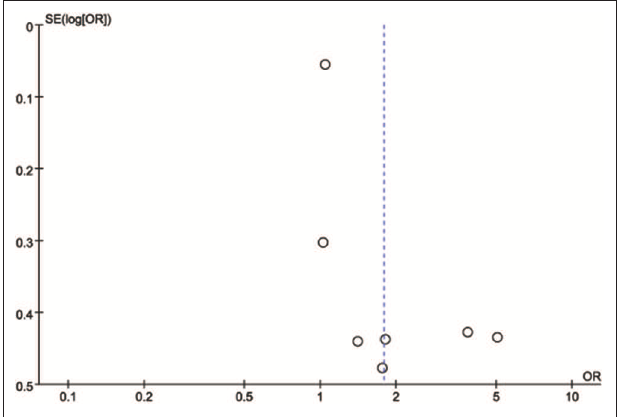
FIGURE 2 | Funnel plot analysis. SE, standard error; OR, odds ratio.